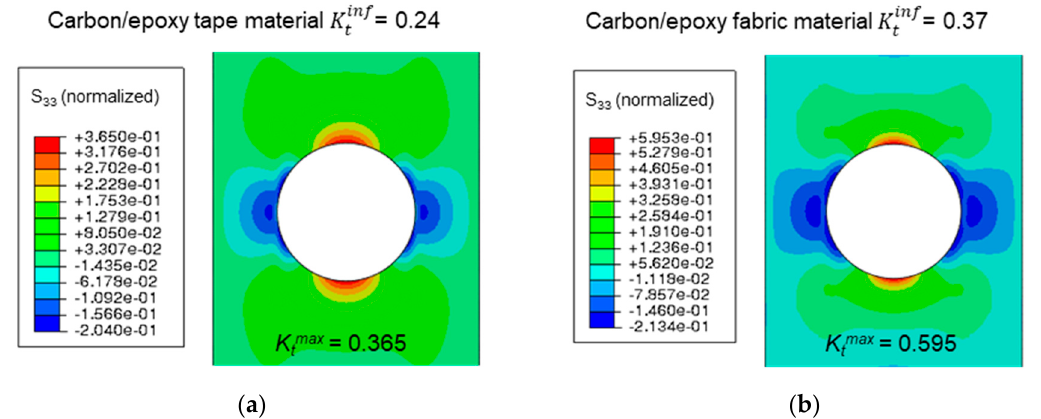
Figure 7. ILT stress concentration in a typical unidirectional OHC specimen using FE analysis for ( a ) the carbon/epoxy tape and ( b ) the carbon/epoxy fabric materials considered in this